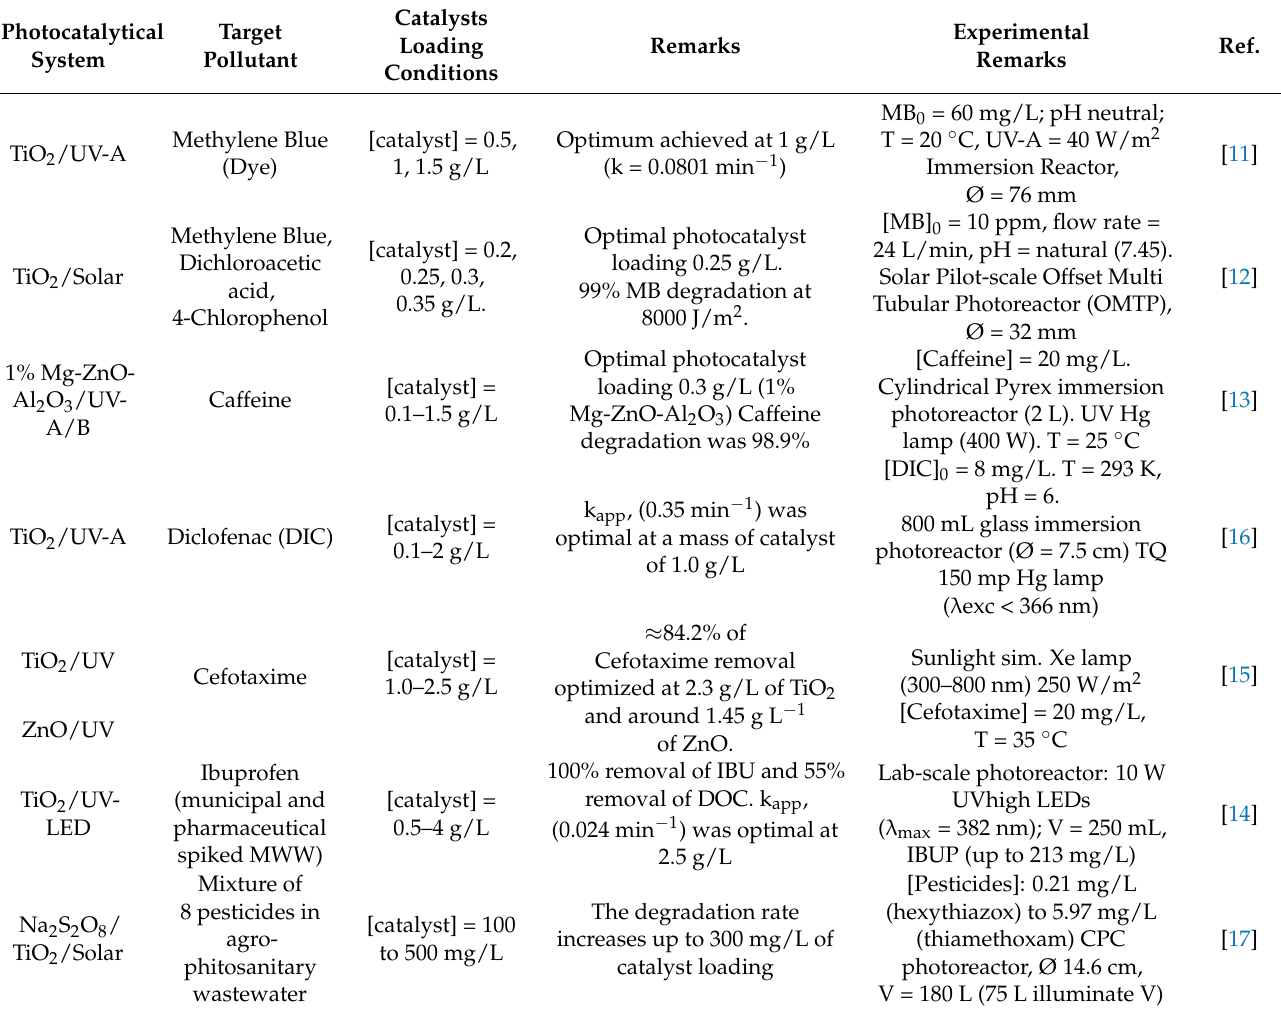
Table 1. UV-AOPs intensification by catalyst loading